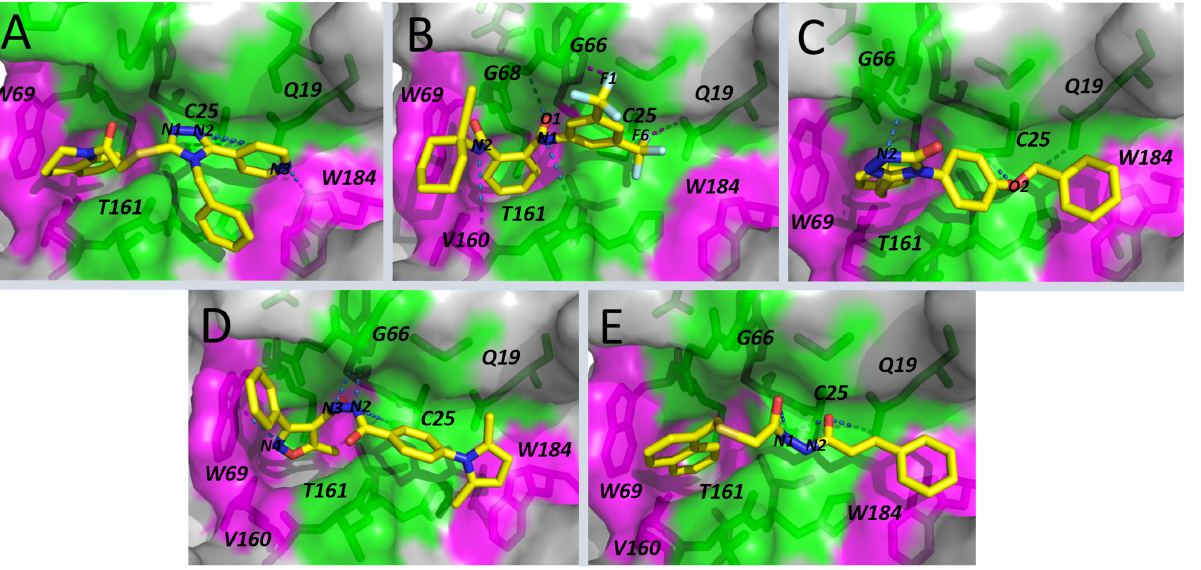
Fig 3. Selected docking poses for the best five hits. FhCL3 in complex with HTS12701 (A), BTB03219 (B), SPB07884 (C), HTS11101 (D) and RH01594 (E). FhCL3 interacting residues as well as ligand atoms involved in possible hydrogen (blue dashed lines) and halogen (purple dashed lines) bonds are labeled. Protein surface is colored according to its polar (green) and non-polar (magenta)